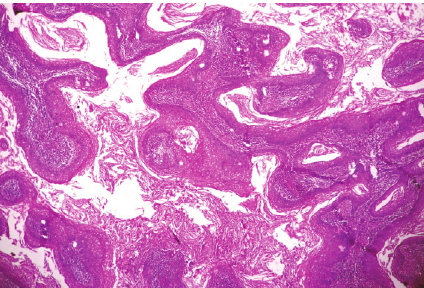
Figure 2: Arborizing papillomatosis with parakeratosis and acan- thosis (H&E, × 100).